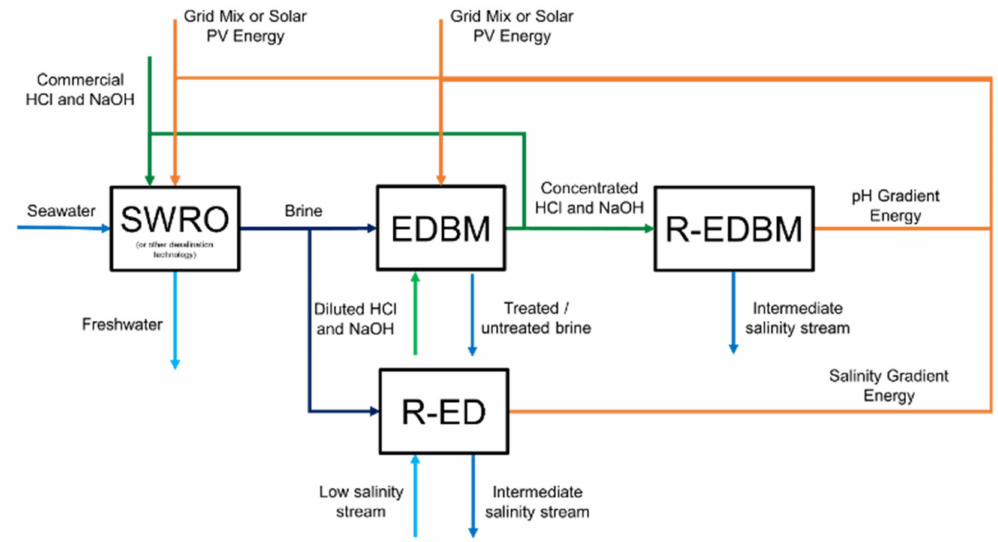
Figure 7. Alternative A5 flow